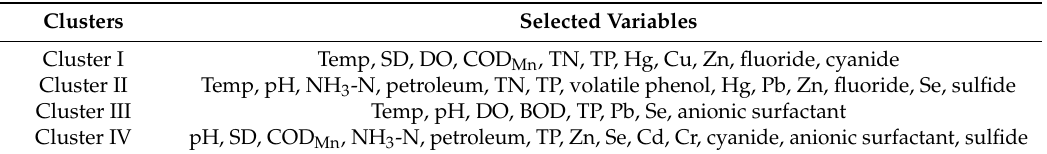
Table 4. The results of input variables selected from 23 parameters for each cluster.